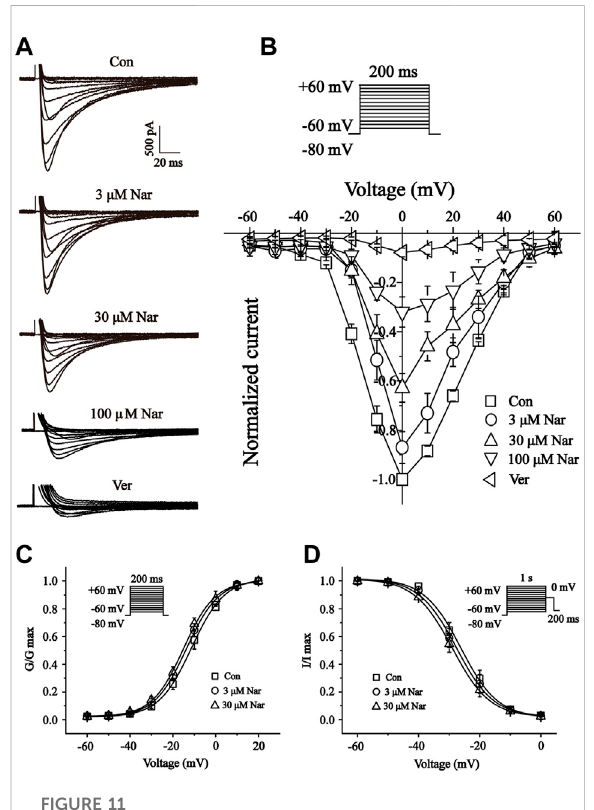
FIGURE 11 Effects of Nar on the current-voltage relationship (I-V curve) of I Ca-L , and the effects of Nar on activation and inactivation properties of I Ca-L . (A) Representative recordings of I Ca-L from isolated cardiomyocytes treated with Con, Nar (3, 30 and 100 μ M)andVer(10 μ M)conditions. (B) I-VcurveofI Ca-L withCon, Nar (3, 30 and 100 μ M) and Ver (10 μ M) conditions. Voltage dependence of (C) ICa-L activation and (D) steady-state inactivation in the Con and Nar (3 and 30 μ M) conditions. Values were expressed as the mean ± SEM, each group has eight to 10 cells from seven rat hearts.